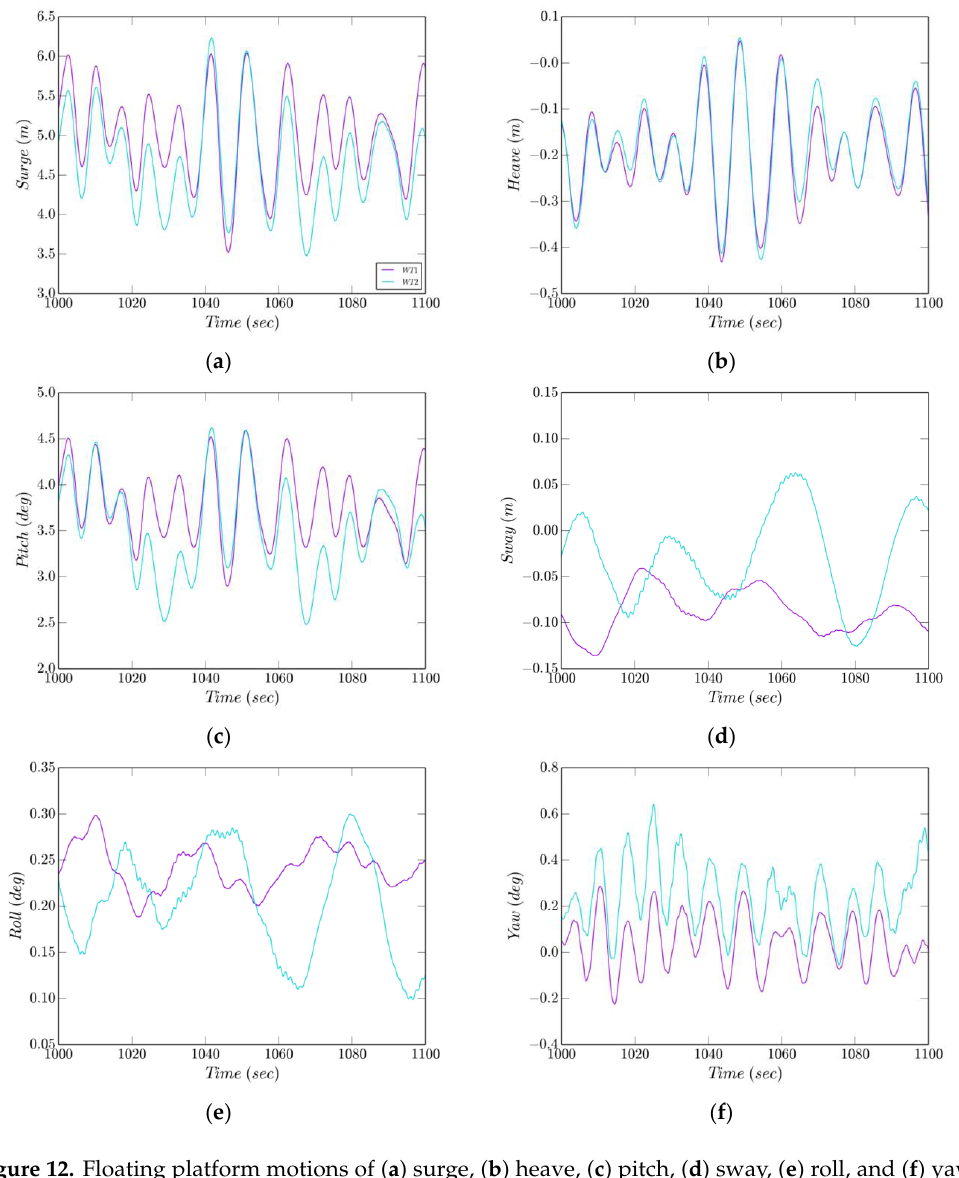
Figure 12. Floating platform motions of ( a ) surge, ( b ) heave, ( c ) pitch, ( d ) sway, ( e ) roll, and ( f ) yaw from SOWFA.